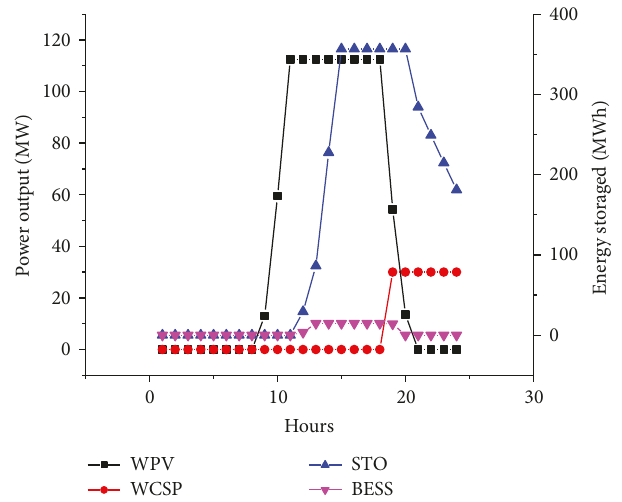
Figure 7: The system output power of Equinox Day of Equinox Day Optimization. Figure 6: Comparison between the power generation capacity of